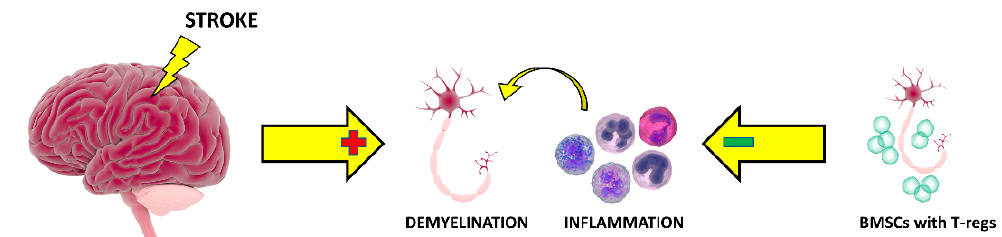
Figure 1. T-regulatory cells sequester stroke-induced inflammation leading to less demyelination.